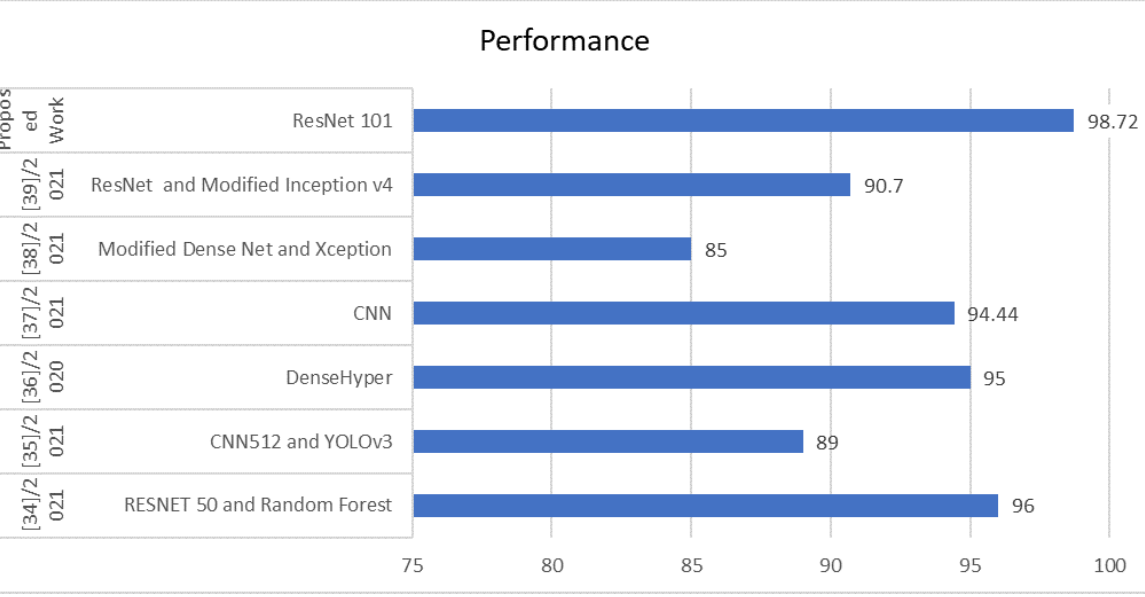
Figure 13. Proposed model compared to existing approaches.